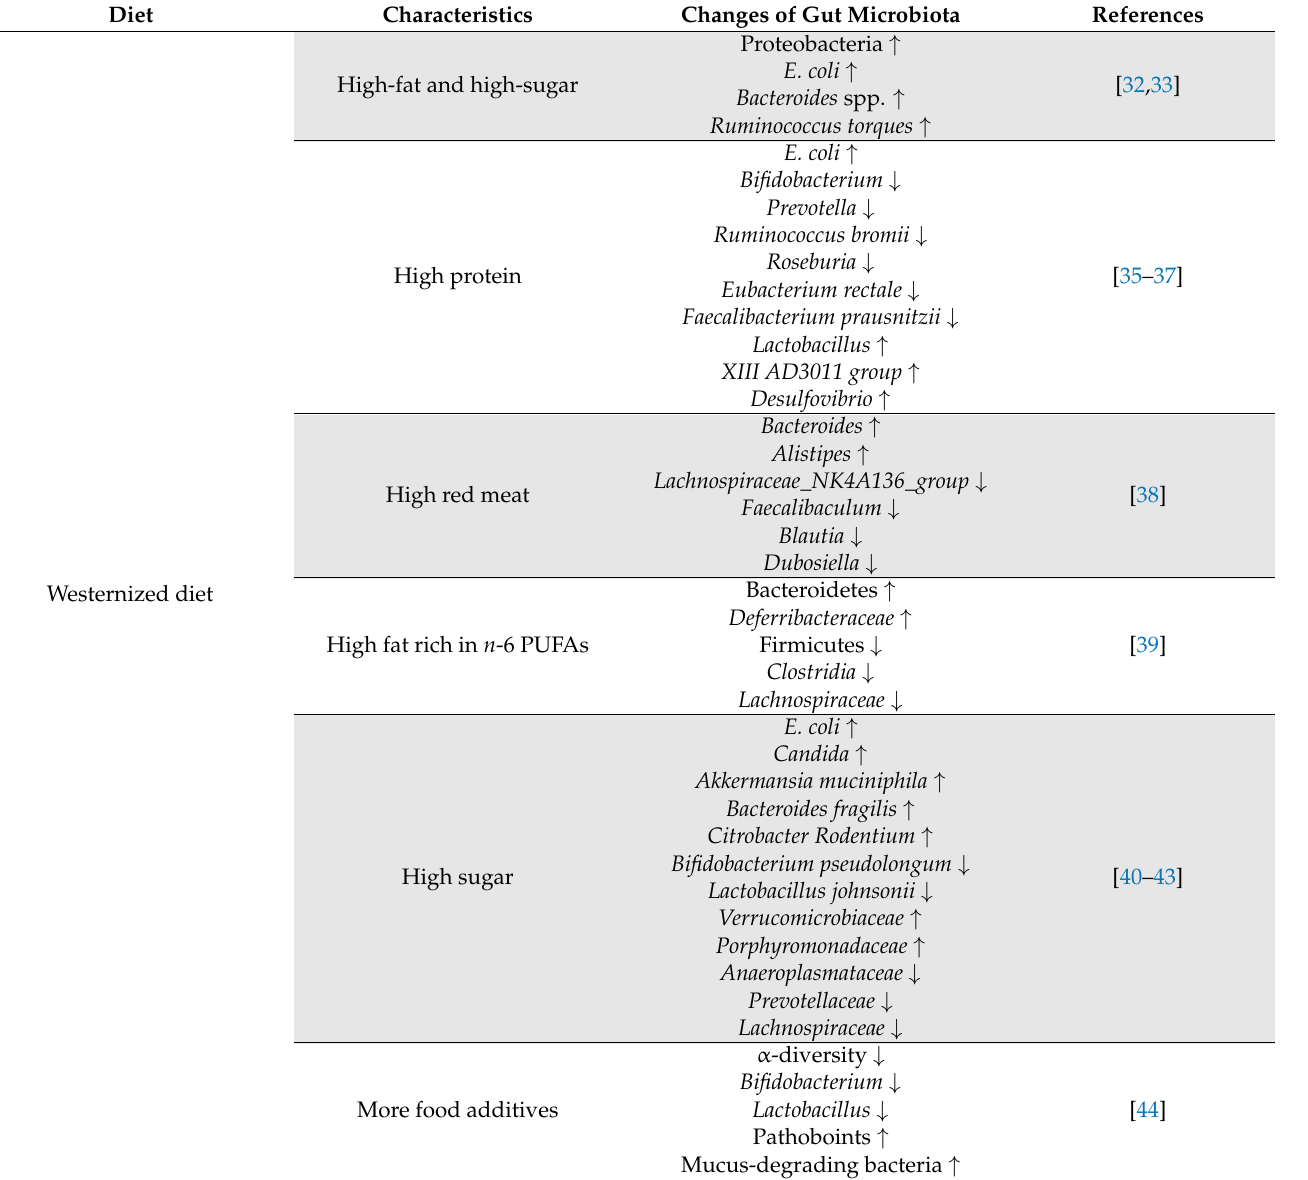
Table 1. Characteristics of the Westernized diet and pro-inflammatory diet and gut microbiota